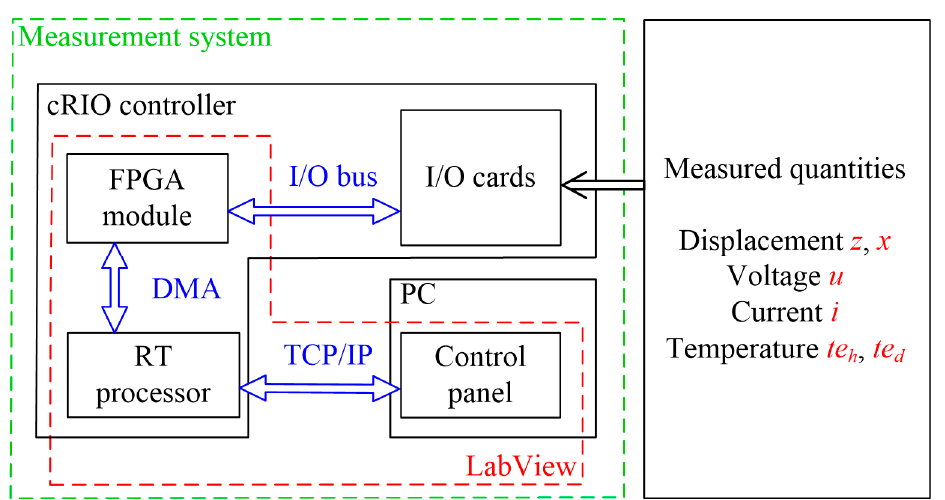
Figure 5. Measurement system layout.